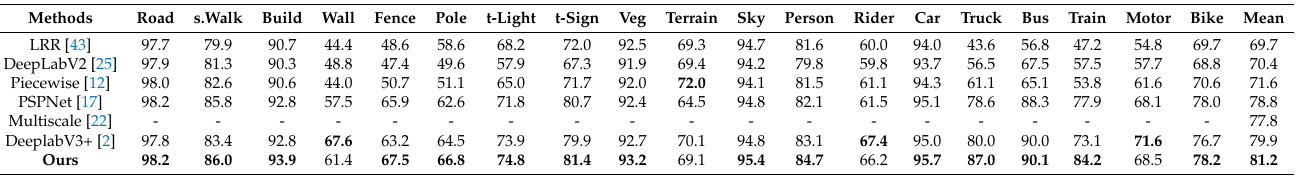
Table 1. Comparison of our IFBFNet with DeepLabV3plus and other state-of-the-art networks on the Cityscapes validation set in terms of class IoUs and mean IoU.The blackened figure is the data with the highest index.